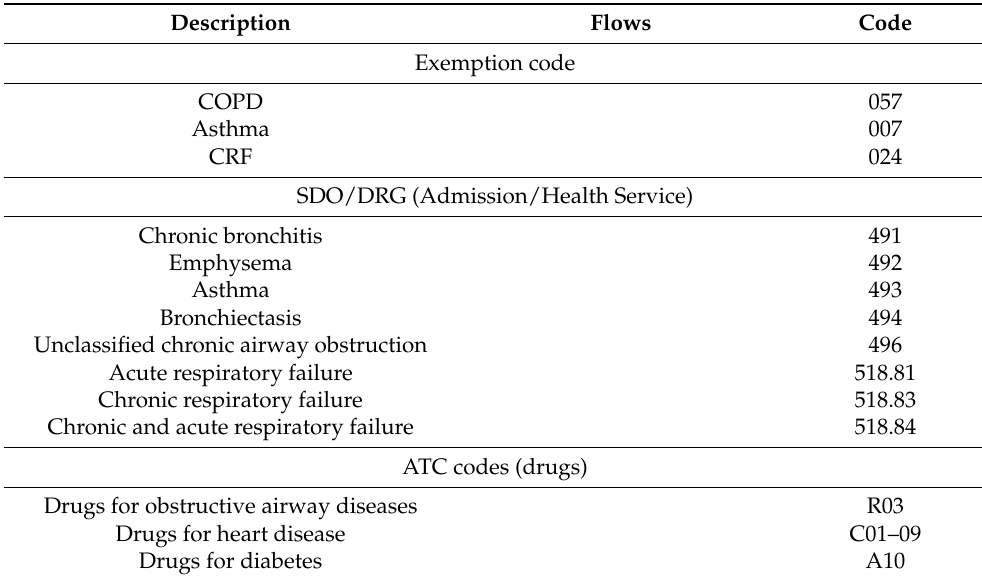
Table 2. Identification codes (exemption codes, SDO/DRG codes and ATC codes) for subjects with chronic respiratory diseases according to PUGLIA CARE